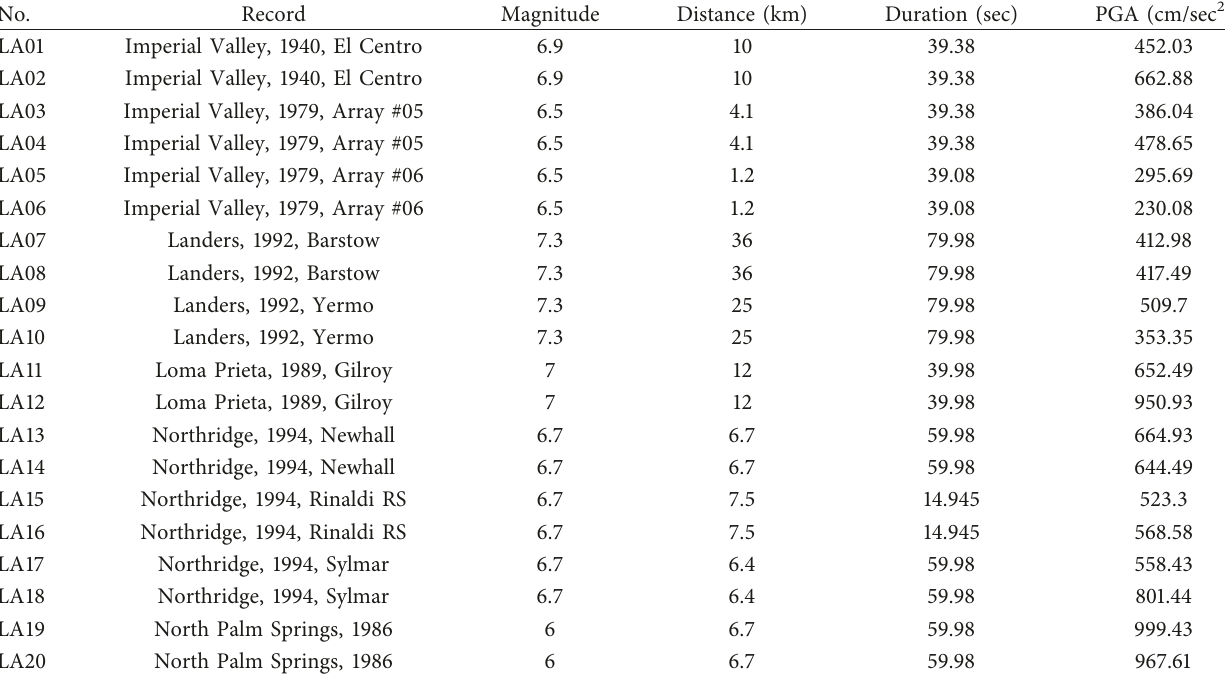
Table 3: Ground motions of LA 10%/50yr